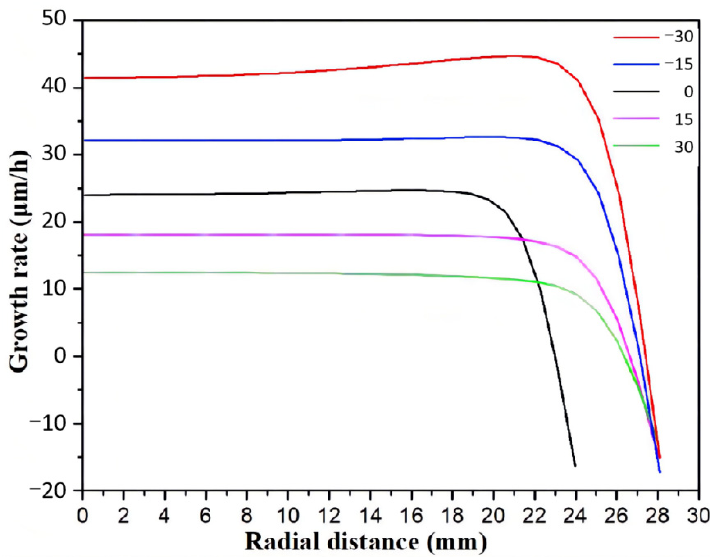
Figure 6. Effect of heating body position on crystal growth rate.